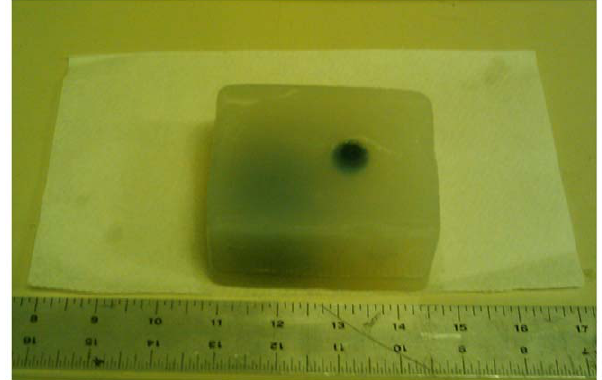
Figure 3. Ultrasound Phantom. Agar based 3.5 0 x2.75 0 x2 0 box shaped phantom with embedded marble ball, peach pit and two cherry pits. The marble ball and the peach pit can be seen from the image.